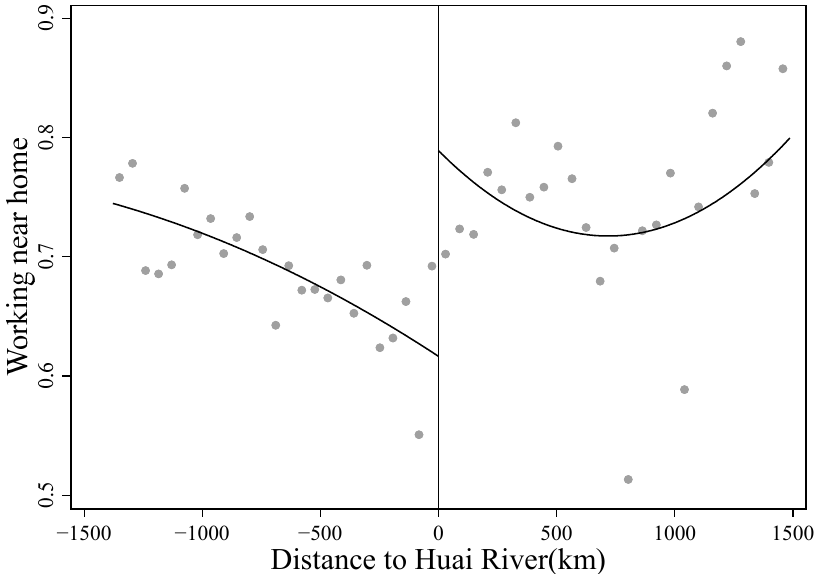
Figure 3. RD plot for work. Note: The figure shows the binned averages of working near home against the running variable. The solid line represents a quartic polynomial fit of working near home on each side of the threshold.